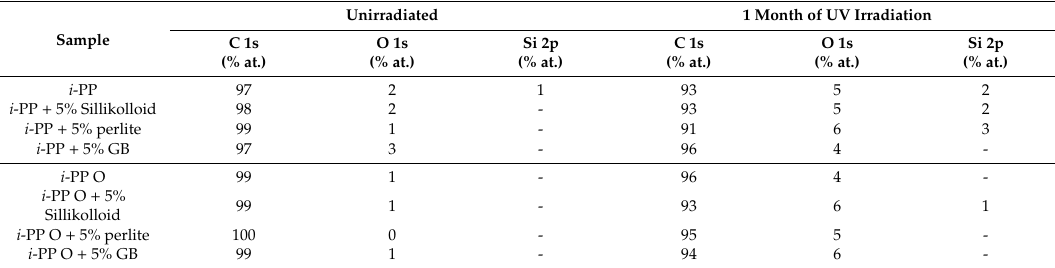
Table 4. Surface concentration of elements calculated from X-ray photoelectron spectroscopy (XPS) for the unoriented and oriented (O) isotactic-polypropylene ( i -PP) films with 5% of Sillikolloid, perlite, and glass beads (GB) for the samples before UV irradiation and after one month of irradiation.